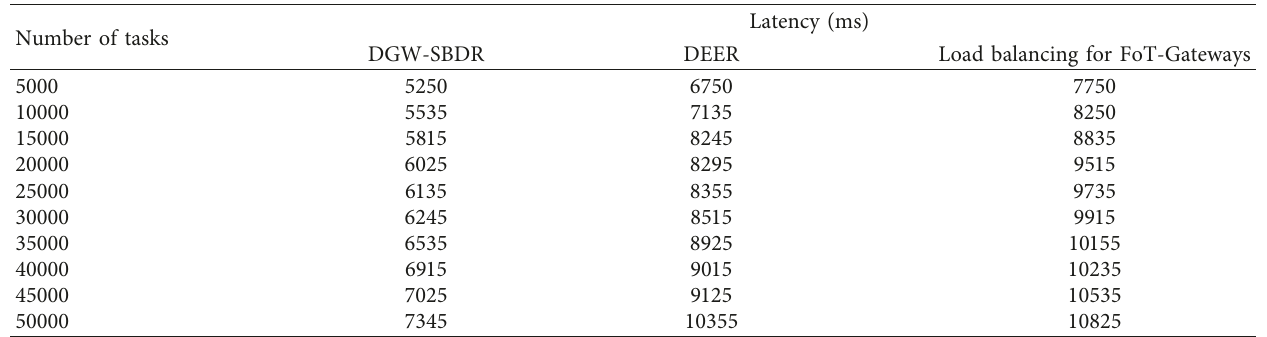
Table 5: Simulation results for latency.